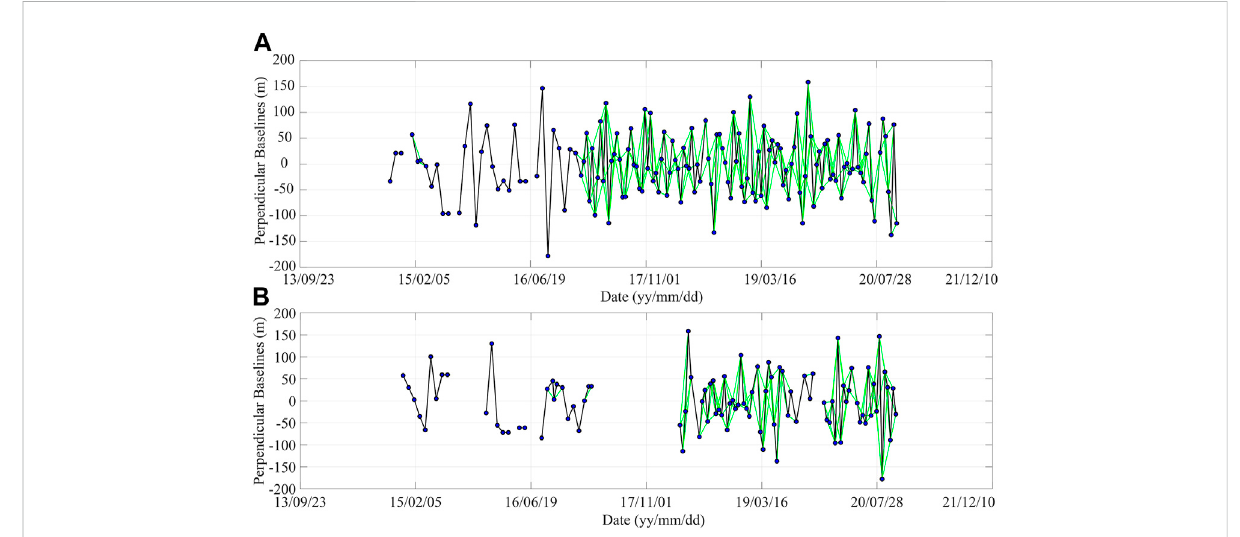
FIGURE 2 Image acquisition and perpendicular baselines of (A) ascending track AT 26 and (B) descending track DT 135 from Sentinel-1 data in the study area. The blue dots indicate the individual SAR acquisitions and lines show interferogram pairs. The black lines are for sequence acquisitions and the green lines show redundant interferograms used with no-more-than 36 days. Note that for the descending track, images acquired before 2018 are irregularly sampled in time due to much fewer